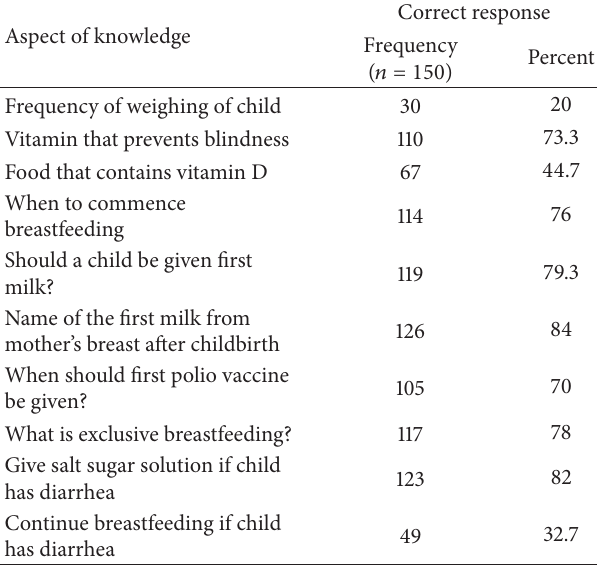
Table 4: Adequacy of knowledge of child survival